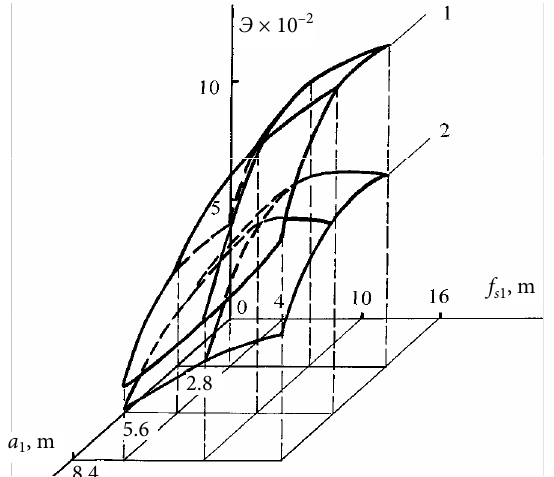
Fig. 10. Effectiveness of the cable net materials use for max vertical displacements decrease Э vs the initial deflection f s 1 of cable truss top chord and distance a 1 between the support points of tie-bars: 1 – displacements of the cable net at the support points are restricted by the guys deformations; 2 – the support points of the cable net are